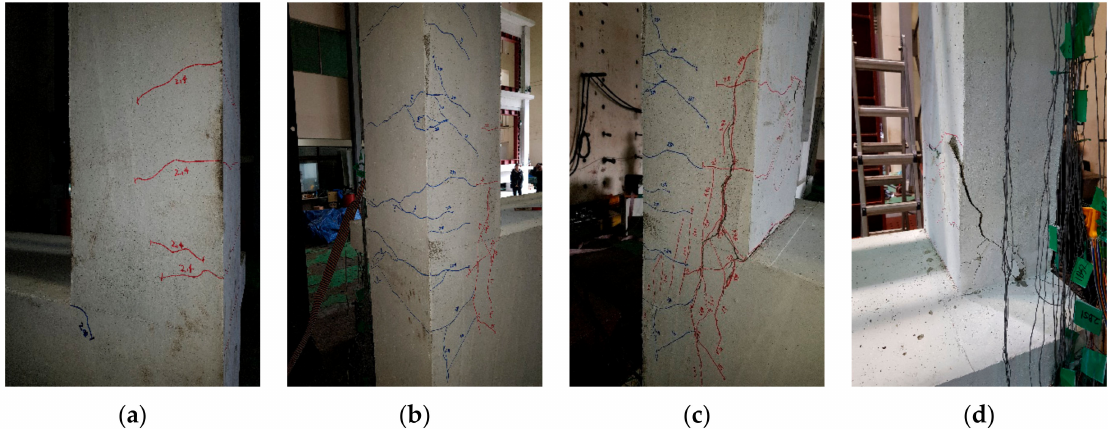
Figure 14. Cracks and ultimate failure of test frame with no reinforcement applied (PD-FR) (200 cm/s 2 ): ( a ) flexural cracks at around 2.4 s (18.2 mm), ( b ) flexural and shear cracks at around 2.89 s (38.9 mm), ( c ) shear cracks and maximum displacement at around 3.46 s (70.2 mm), and ( d ) shear failure and maximum displacement at the final stage of the test.